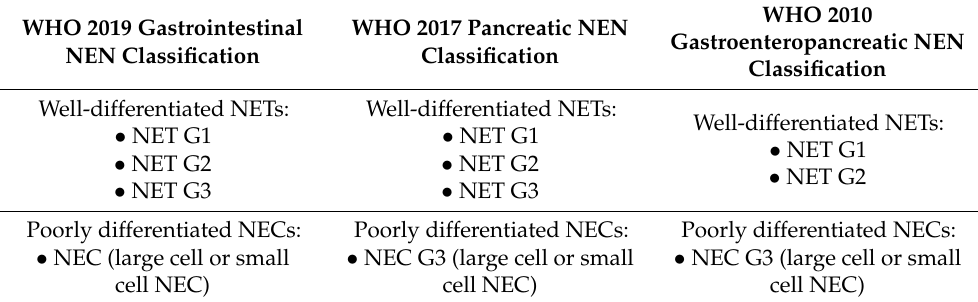
Table 1. WHO classification of Gastroenteropancreatic